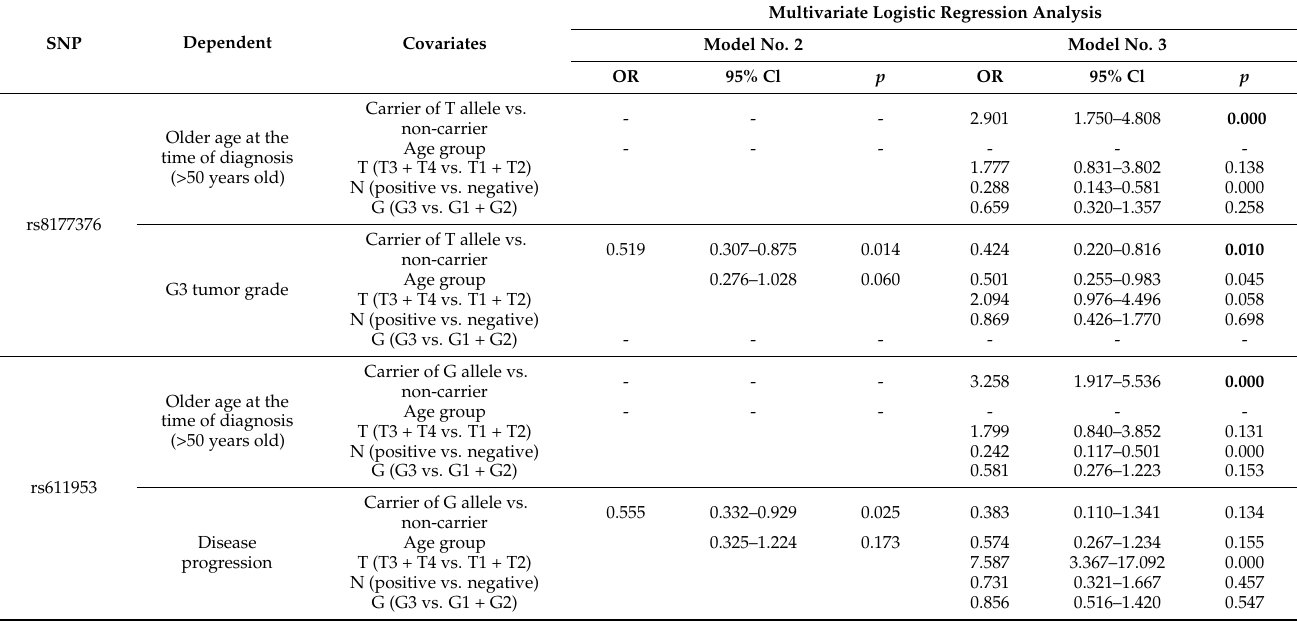
Table 3. Multivariate logistic regression analysis for associations between TIRAP rs8177376, rs611953 and clinicopathological